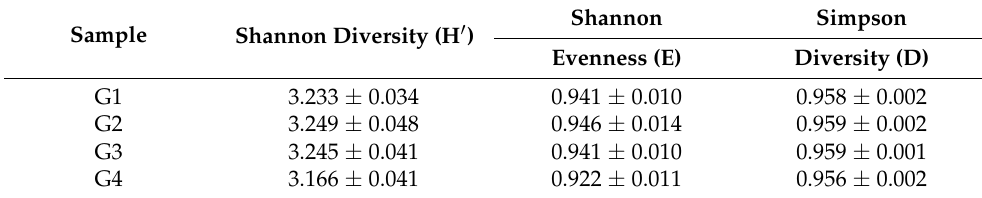
Table 4. Comparison of metabolic functional diversity indices of the sediment microbial communities. Data in the table are expressed as mean ± standard deviation. H (cid:48) stands for Shannon–Wiener diversity index, D stands for Simpson diversity index, and E stands for Shannon evenness